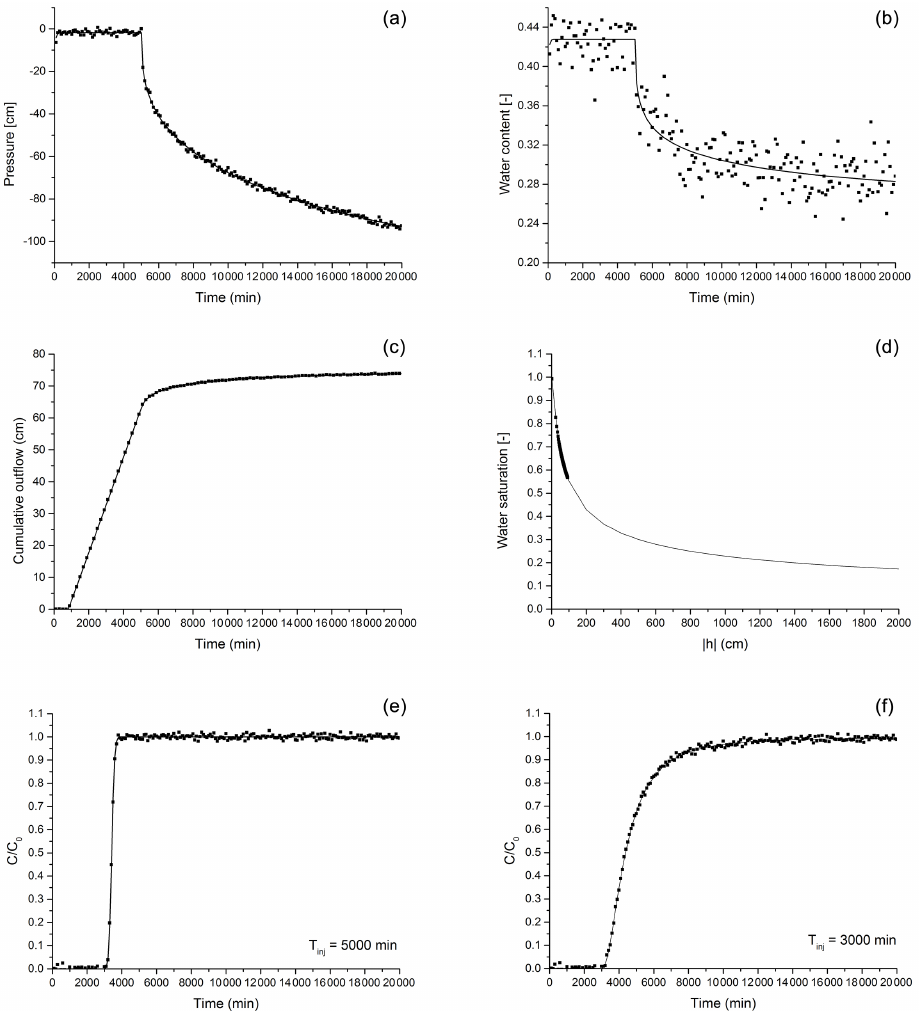
Figure 1. (a) Pressure head at 5cm below the soil surface, (b) water content at 5cm below the soil surface, (c) cumulative outflow, (d) reten- tion curve, (e) output concentration for T inj = 5000 and (f) for T inj = 3000min. Solid lines represent model outputs and dots represent the sets of perturbed data serving as conditioning information for model calibration. Table 3. Summary of the pairwise parameter